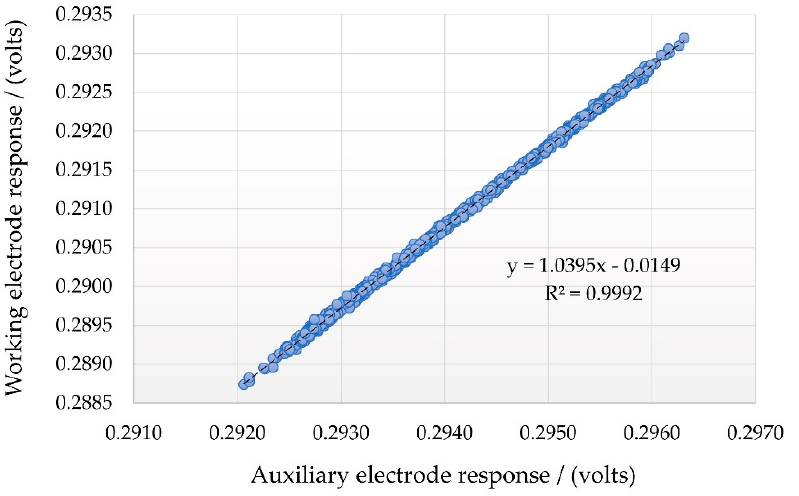
Figure 6. Interrelationship between NO electrodes to minor temperature fluctuations (dT = ±1.2